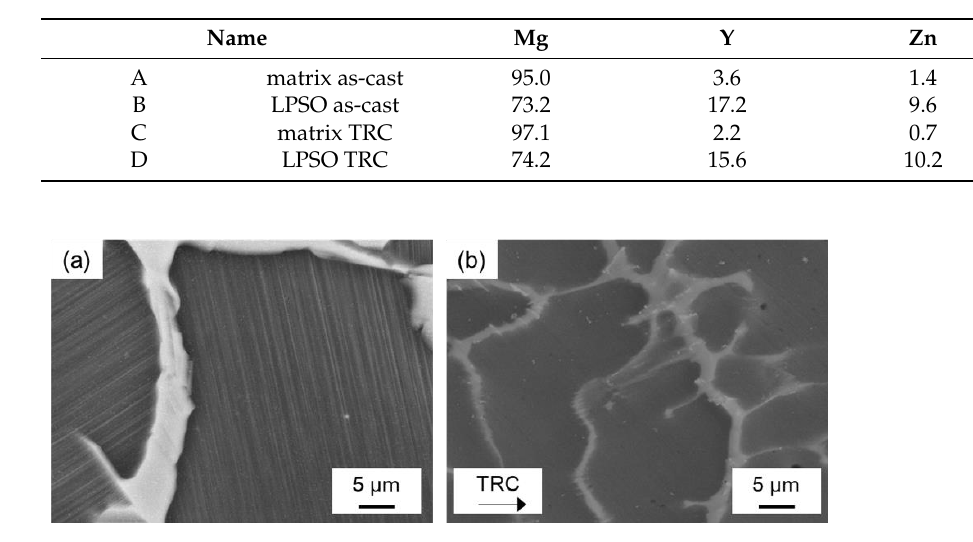
Figure 4. SEM images of the homogenized (500 °C, 2 h) Mg-6.8Y-2.5Zn-0.4Zr alloy after ( a ) con- ventional (20 kV, AsB) and after ( b ) twin-roll casting (15 kV, SE), detailed view